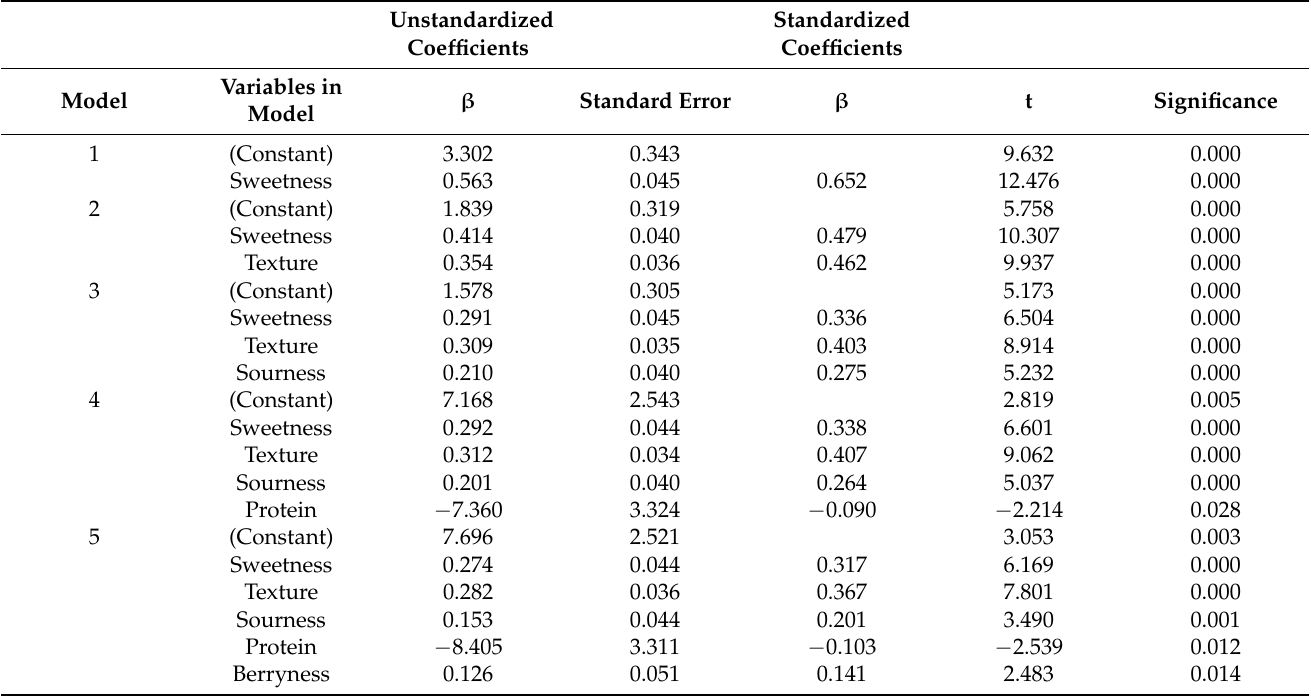
Table A2. Model evolution for stepwise regression.